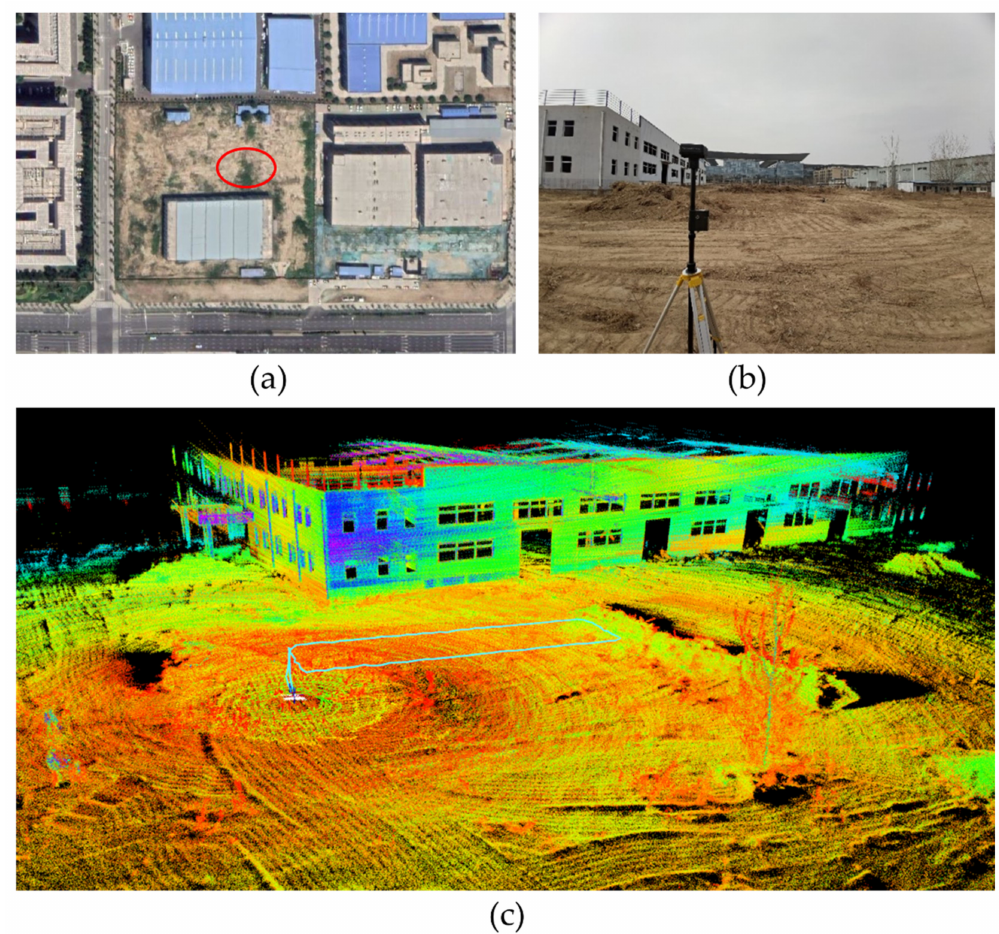
Figure 13. The photos of the test area. Where ( a ) is satellite map of the test site, the red circle is the approximate test area. ( b ) is the original environment of the test site. ( c ) is the flight path of a test in the point cloud